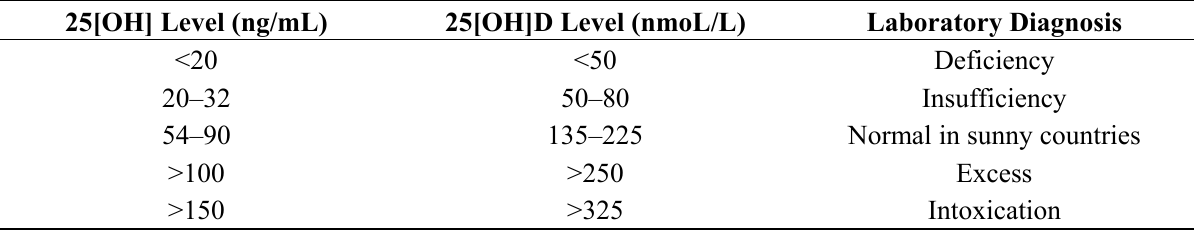
Table 2. Diagnostic Cut-Offs of levels of serum